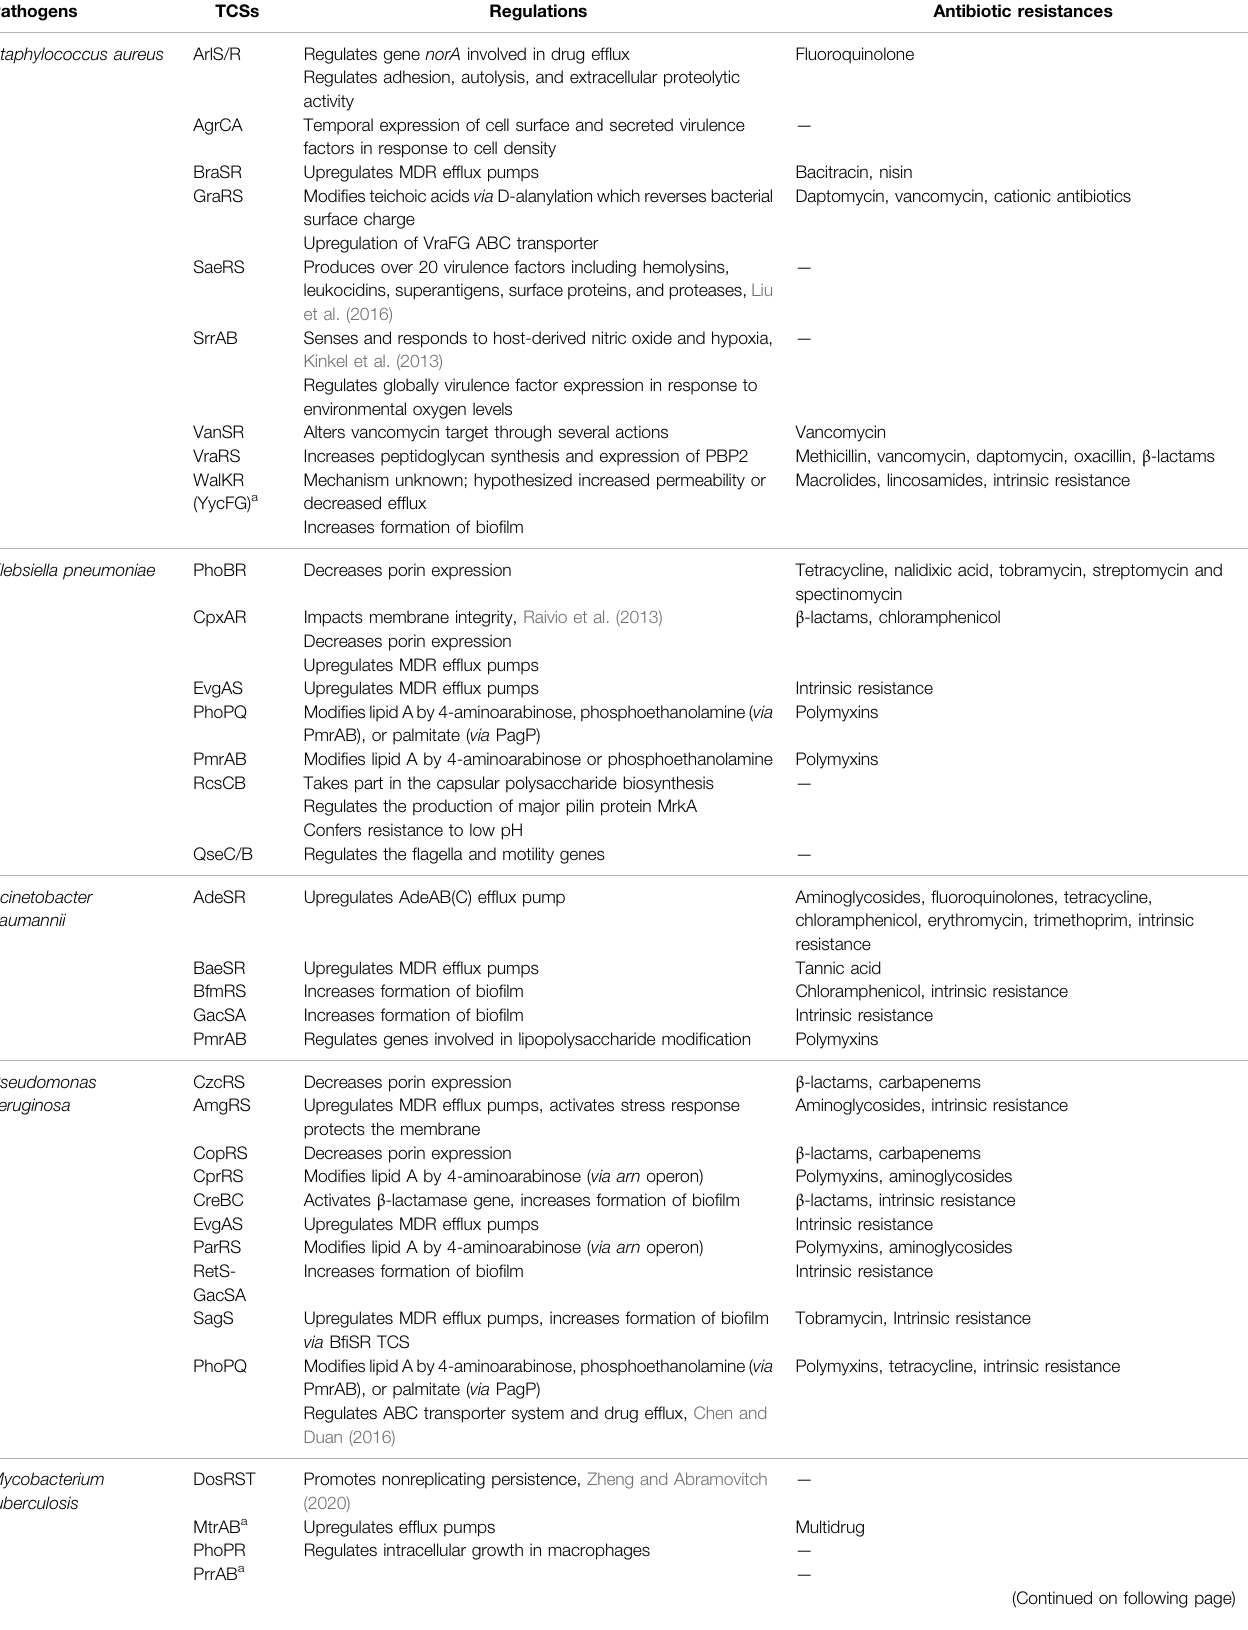
TABLE 3| TCSs implicated inbacterialvirulenceandantibioticresistance(Stephenson andHoch,2002;Bemetal.,2015;Bhagirathetal.,2019;Tierneyand Rather, 2019).